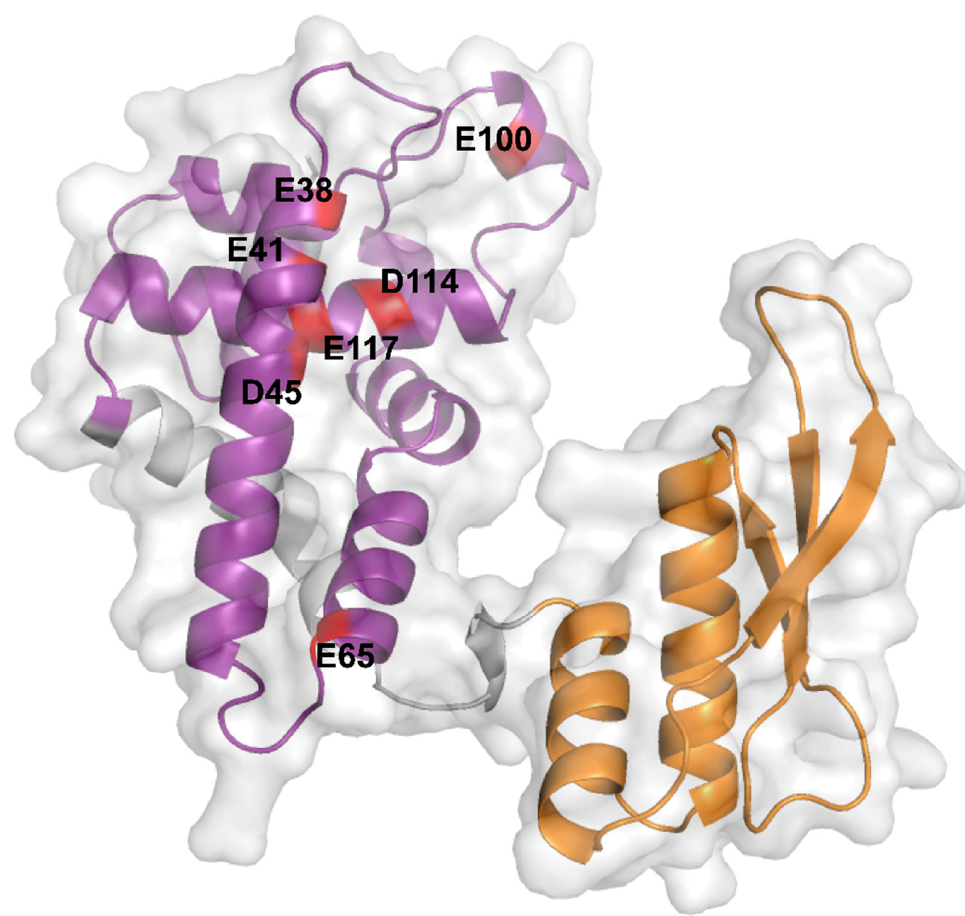
Figure 1. AlphaFold prediction of the Ec-RNase III structure. Ec-RNase III structure predicted by the AlphaFold program (AF-P0A7Y0-F1, https://alphafold.ebi.ac.uk, accessed on the 11 October 2021). The N-terminal RIIID (6-128) and C-terminal dsRBD (155-225) are depicted in purple and orange, respectively. Critical negatively charged residues E38, E41, D45, E65, E100, D114 and E117, which are highly conserved among bacterial RNase III enzymes, are highlighted in red on the structure of the Ec-RNase III. The representation was generated using the PyMol software version